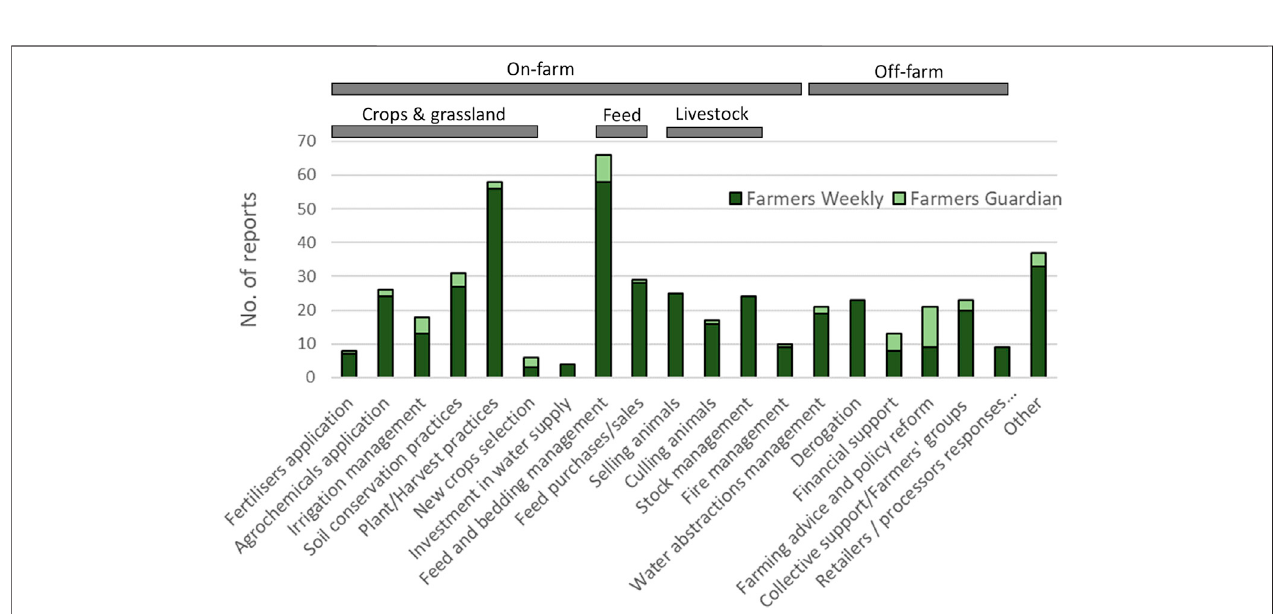
FIGURE 4 | Drought management responses reported in Farmers Weekly and Farmers Guardian trade magazines in 2018.